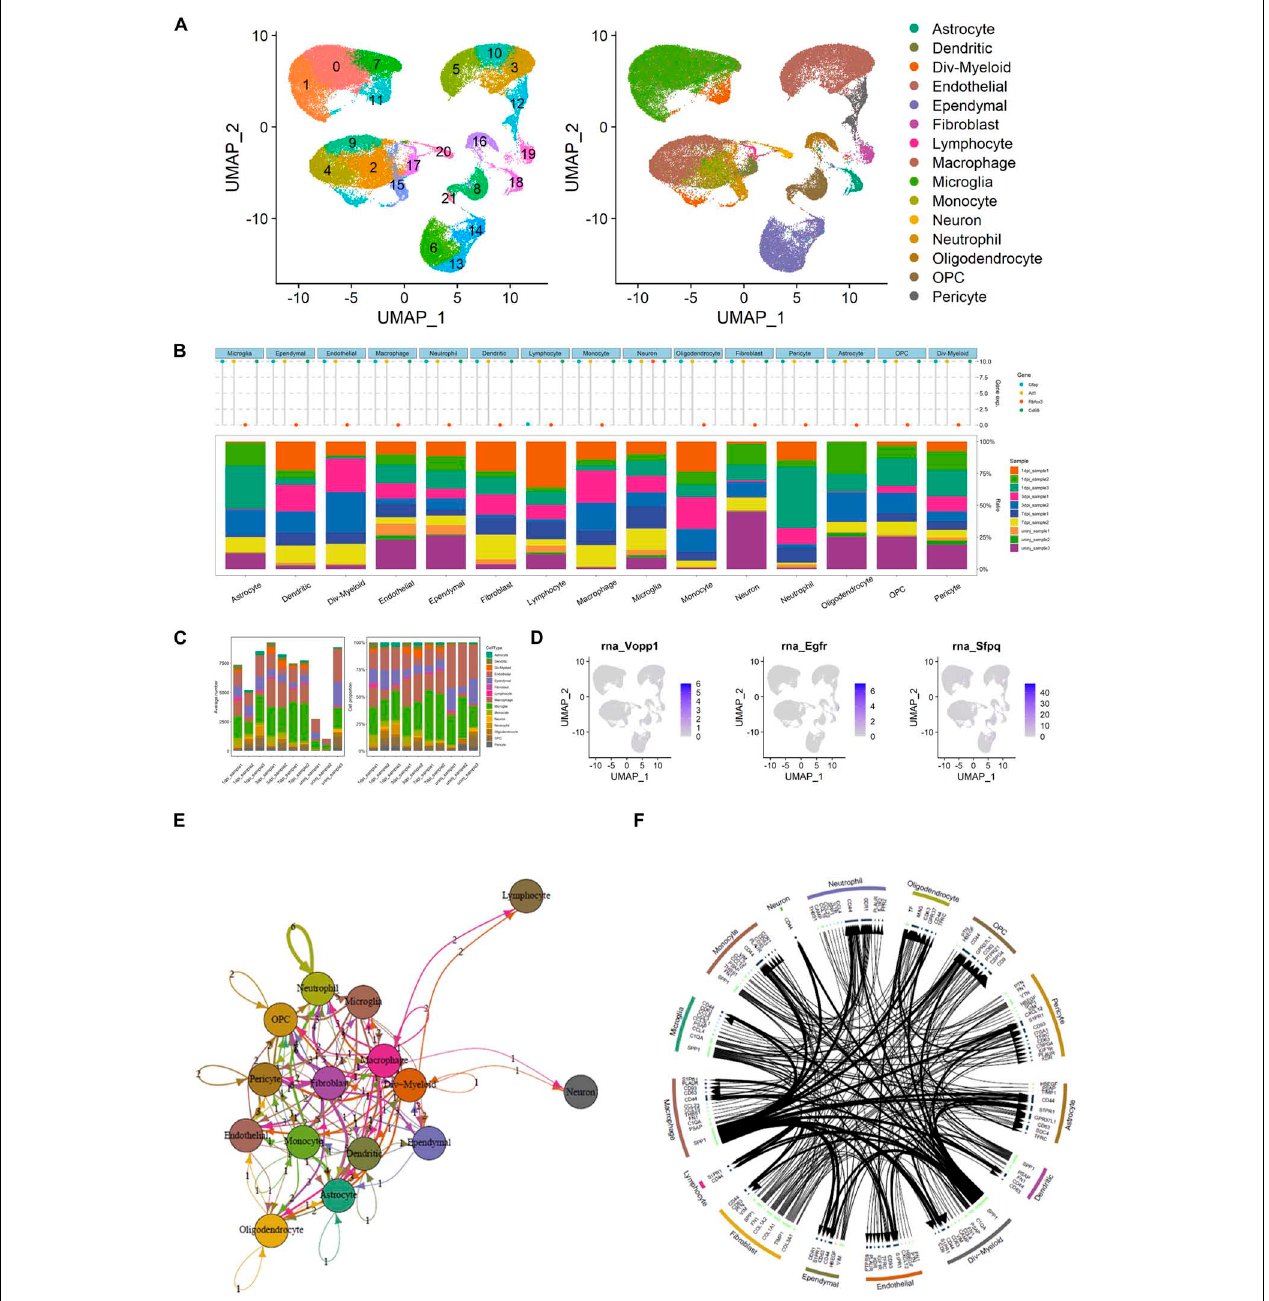
FIGURE 7 | Integrated analysis of single-cell RNA sequencing (scRNA-seq) and cellular communication. (A) Uniform Manifold Approximation and Projection (UMAP) scatter plots and cellular feature plots showing the cell types and marker genes of each cell type. (B) Dot plot showing gene expression levels of the most significant differentially expressed genes (DEGs) of multiple inflammation cells and neuron. In addition, the proportion of these cells in different spinal cord injury (SCI) samples was also shown in the bar plot. (C) Bar plots showing the average number and cell proportion of these cells. (D) Feature plots of vesicular overexpressed in cancer prosurvival protein 1 (VOPP1), epidermal growth factor receptor (EGFR), and Splicing factor proline and glutamine rich (SFPQ). (E) Network showing the intersected cellular communication genes. (F) Circle plot showing the intersected cellular communication genes.